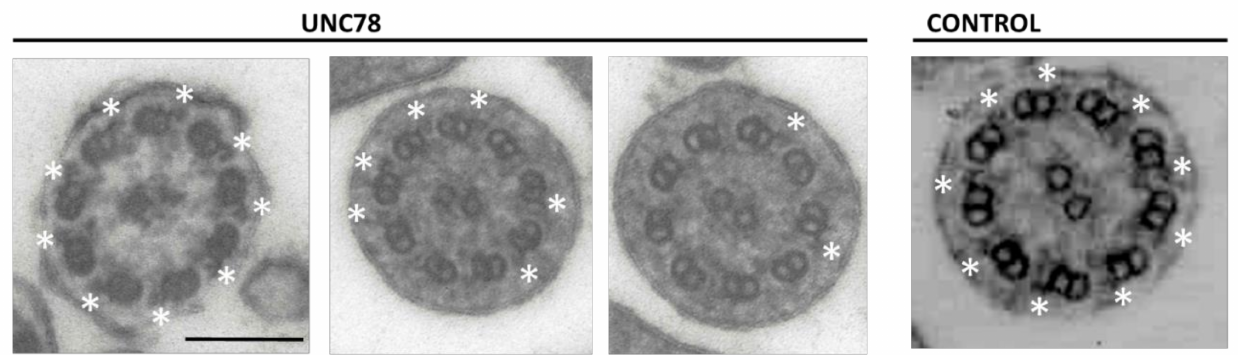
Figure 1. Transmission electron micrographs (TEM) of nasal cilia from subject UNC78 show the presence of normal outer dynein arms (ODA; white asterisks) on multiple cilia. While many ciliary cross-sections showed no ODA, some sections had a completely normal complement of nine. UNC78 (left panels) show 3 examples from subject UNC78; Control (right panel) shows a normal ciliary cross-section. Scale bar = 0.15 µ